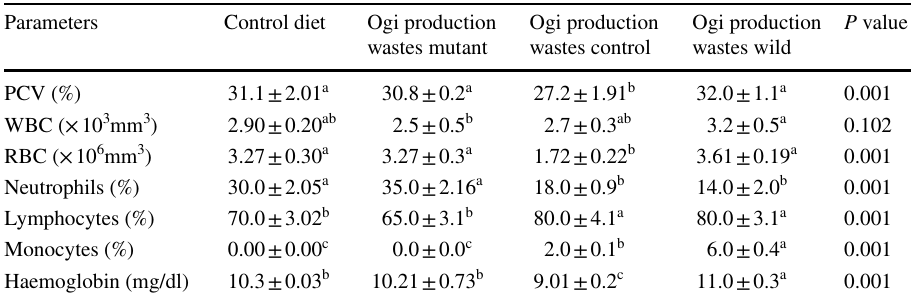
Table 4 Haematological parameters of broiler chicks fed with control diets and mycomeat produced from ogi production wastes using wild and mutant strains of Pleurotus sajor - caju